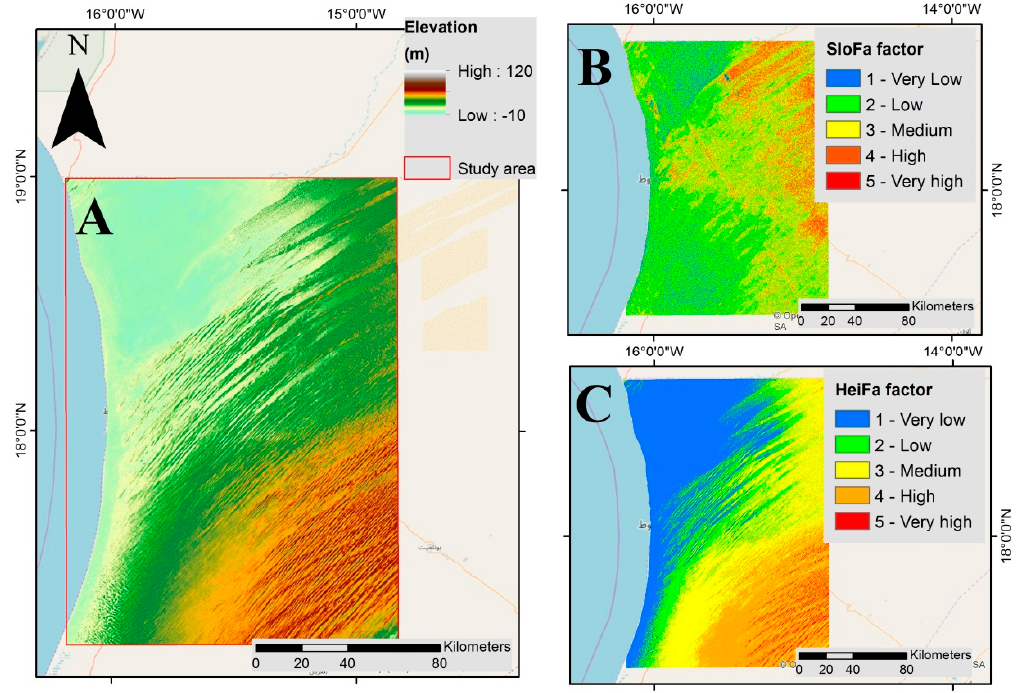
Figure 4. ( A ) Elevation map, ( B ) slope factor (SloFa) and ( C ) height factor (HeiFa).